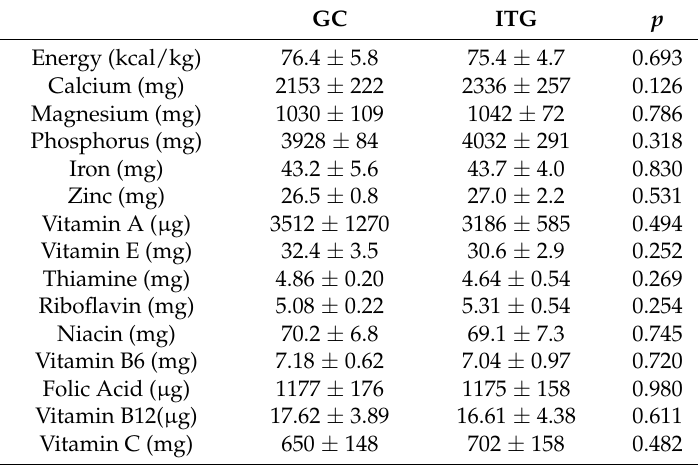
Table 2. Average daily energy and micronutrient intakes in the control group (CG) and iron treatment group (ITG) during the 4 weeks of